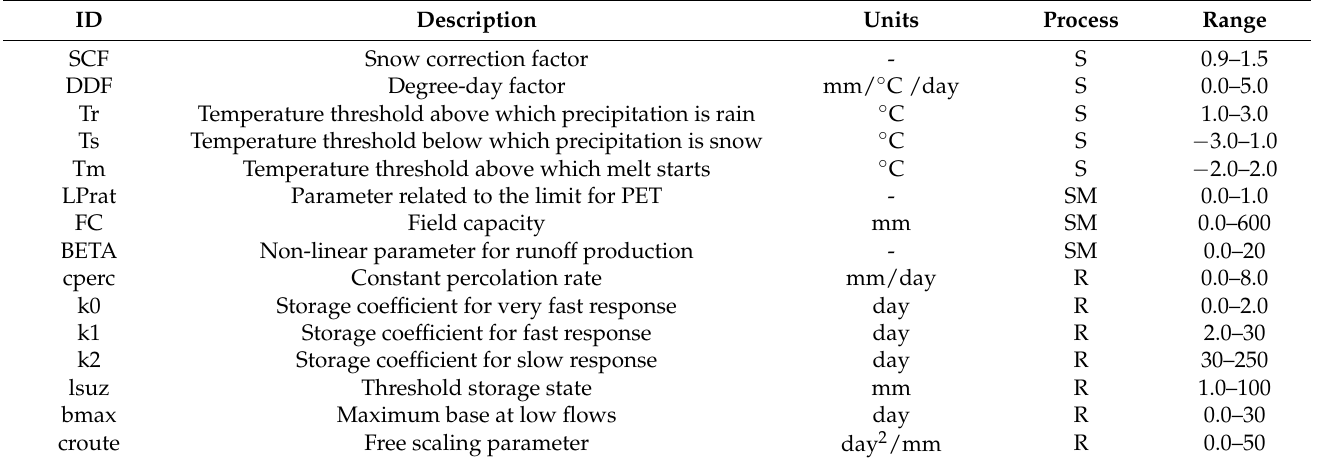
Table 1. TUW model parameter properties. Abbreviations in the process column represent: S, snow; SM, soil moisture; R,